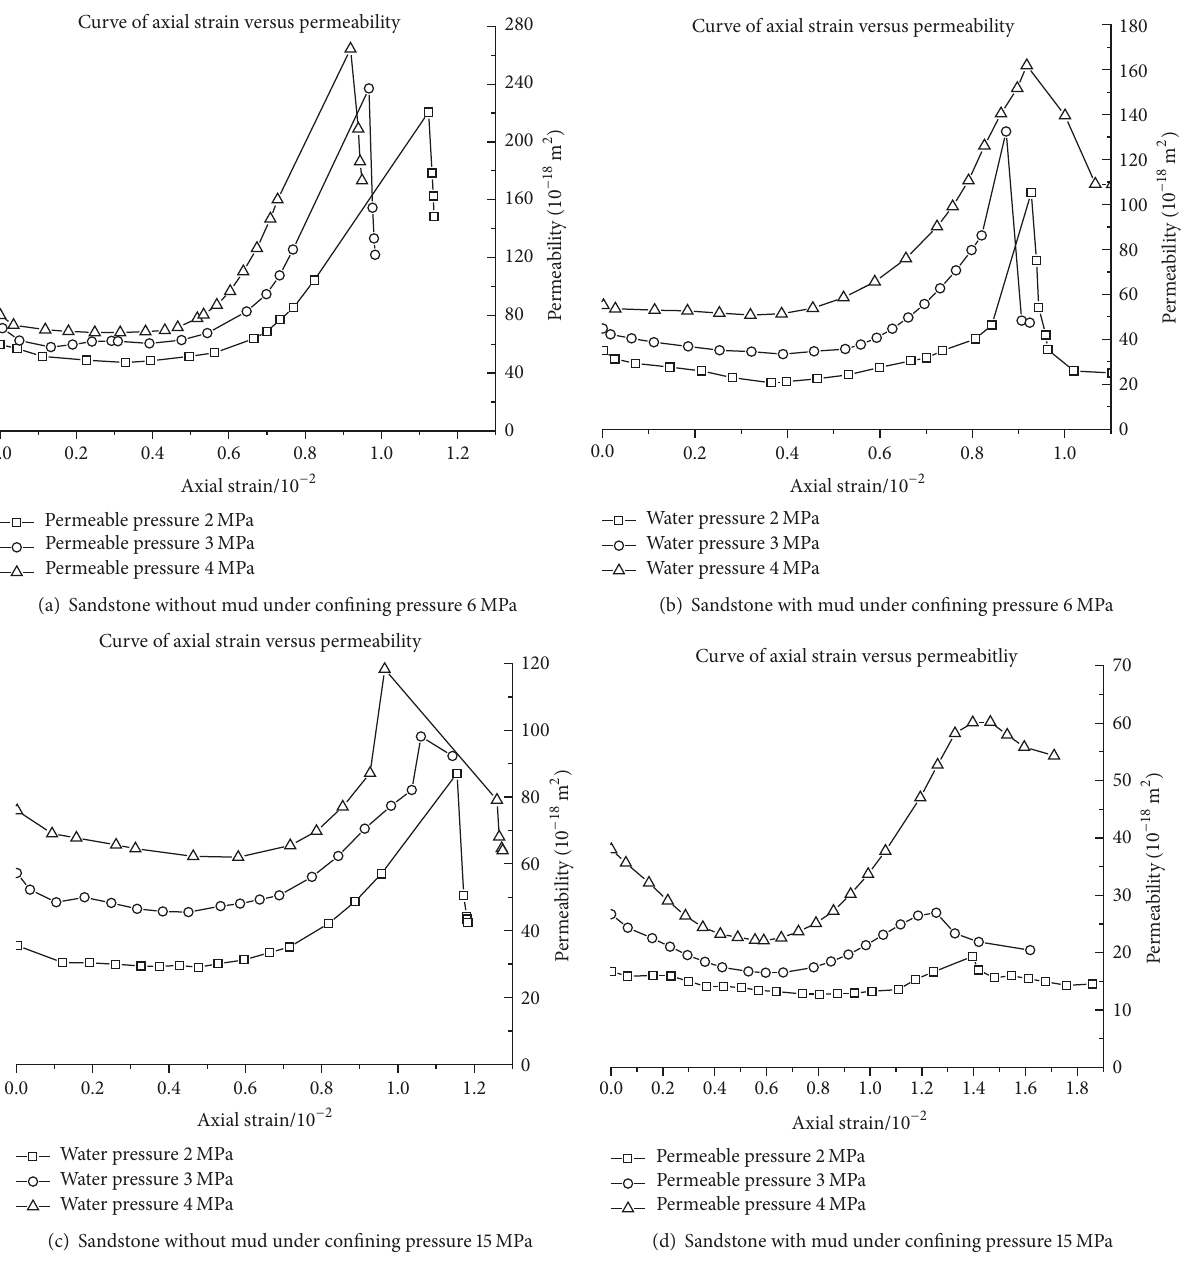
Figure 7: Permeability evolution of two sandstones considering different permeable pressure and confining pressure.